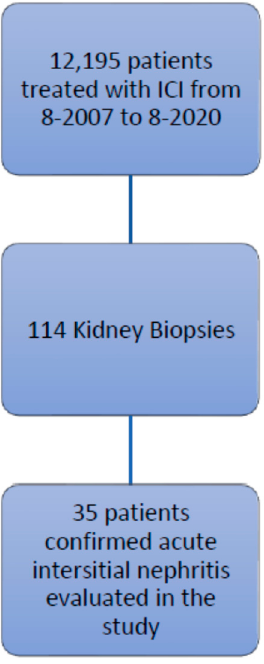
Figure 1. Study flow chart of inclusion criteria.